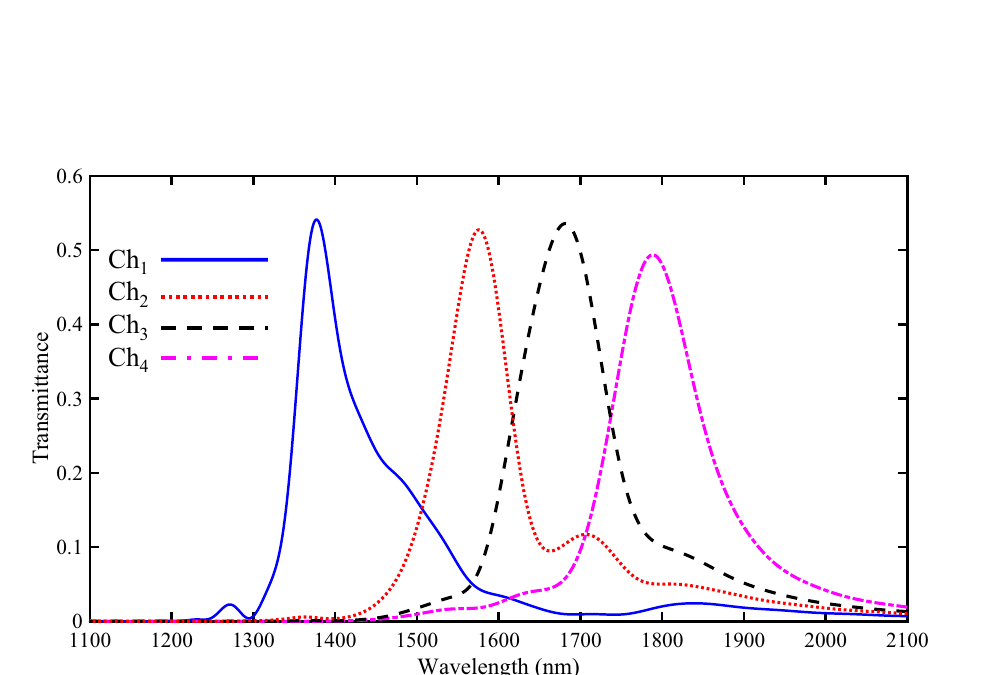
Figure 10. Transmission spectra of the proposed four-channel